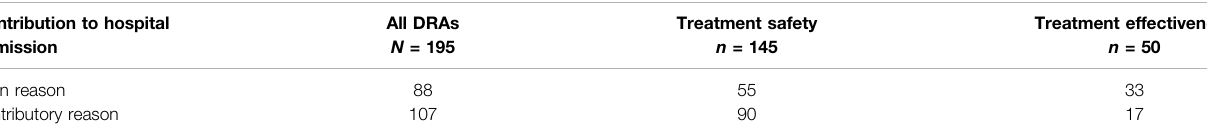
TABLE 9 | Classi fi cation of DRAs — contribution to hospital